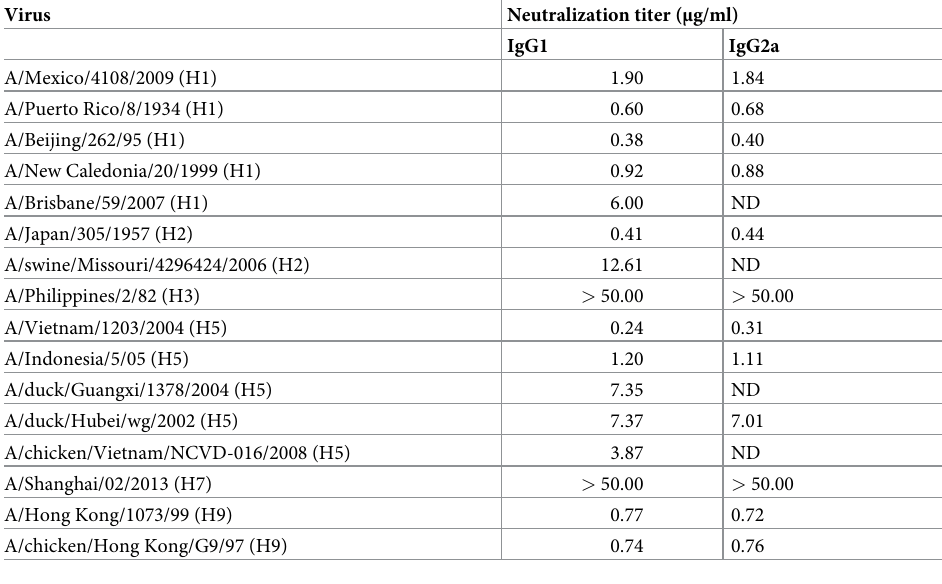
Table 2. Summary of MAb 4C2 neutralization